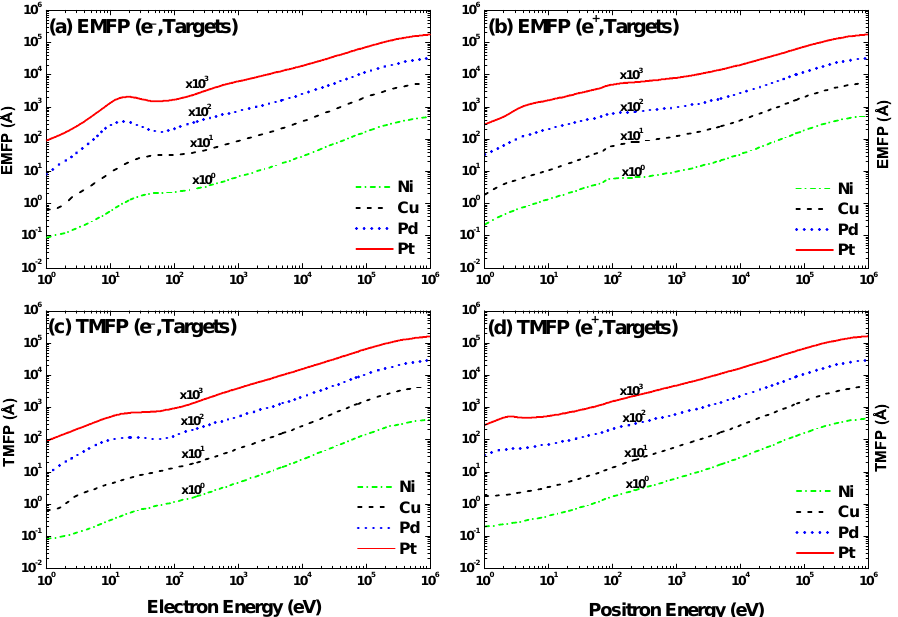
Figure 42. ( a , b ) Elastic mean free path λ el (EMFP) and ( c , d ) total mean free path λ tot (TMFP) in ˙A for ( a , c ) electrons and ( b , d ) positrons colliding with Ni ( − · − · − , green), Cu ( − − −− , black), Pd ( · · · · · · , blue), and Pt (——-, red) as function of collision energy E i